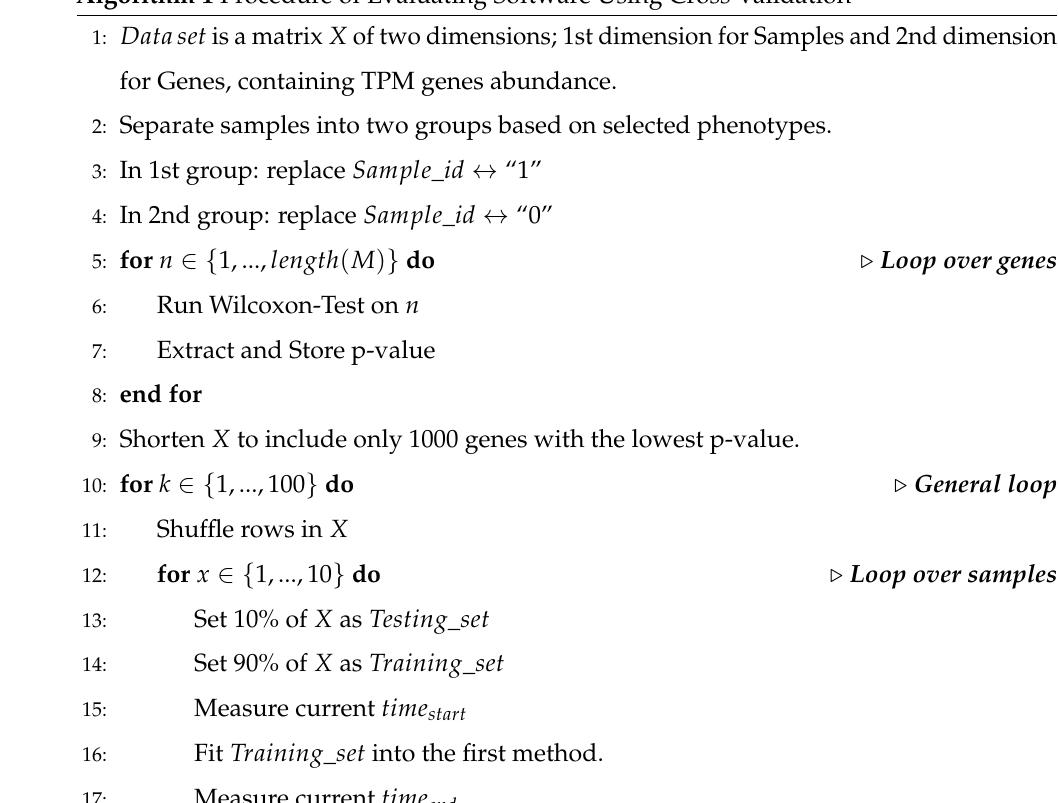
Algorithm 1 Procedure of Evaluating Software Using